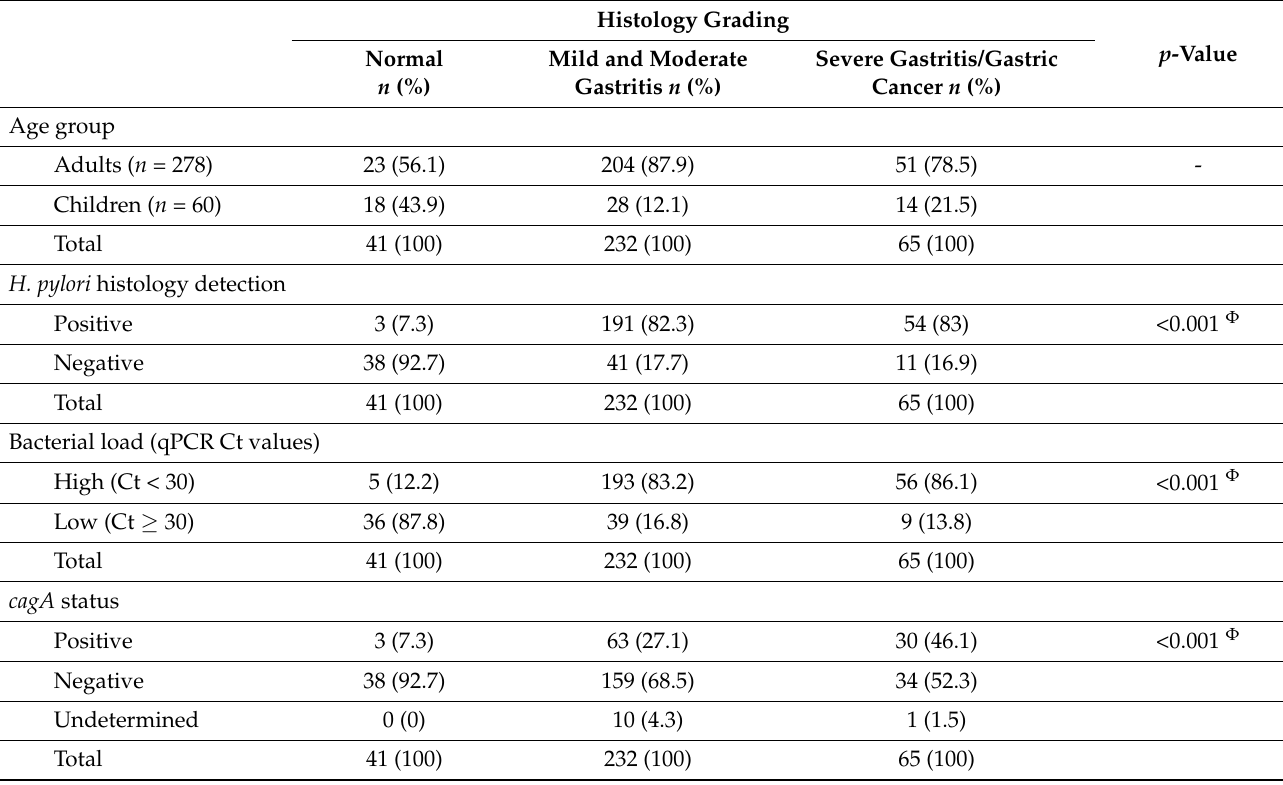
Table 3. Association between presence of H. pylori on histology, bacterial load (qPCR), cagA status of the strain and severity of histology lesions in 338 H. pylori -positive biopsies (278 adults and 60 children).